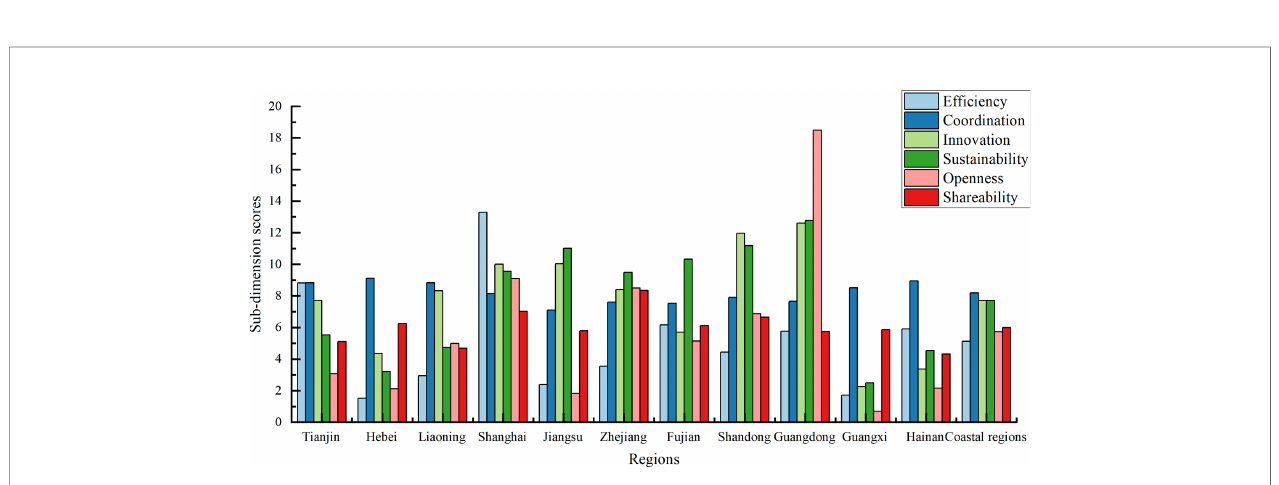
FIGURE 2 | Average contribution rates of the sub-dimension scores to comprehensive scores of China ’ s coastal regions and the three ocean economic circles from